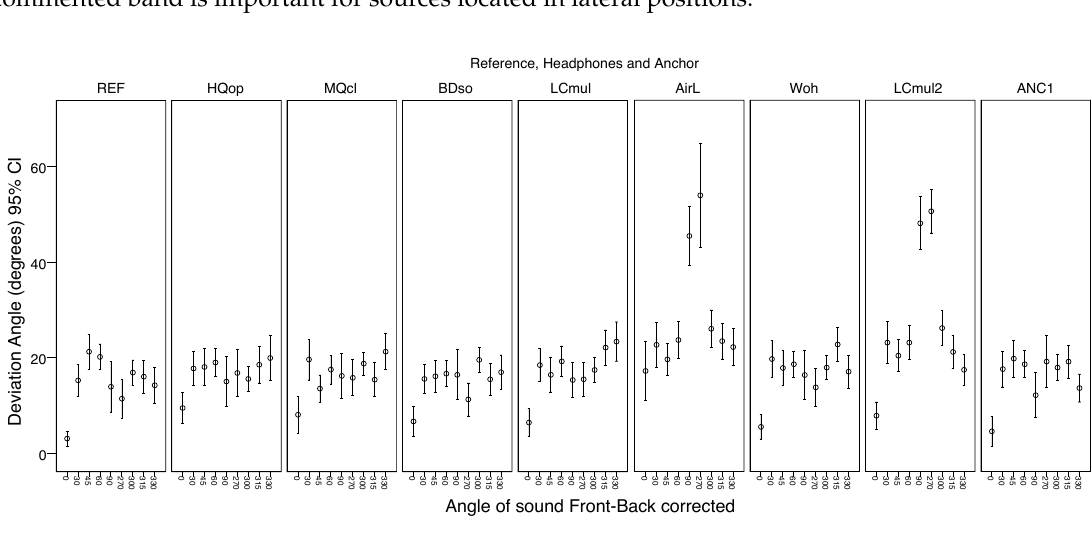
Figure 10. Deviation in degrees of the answers for every reproduced angle of sound. The reference, headphones under testing and anchor are